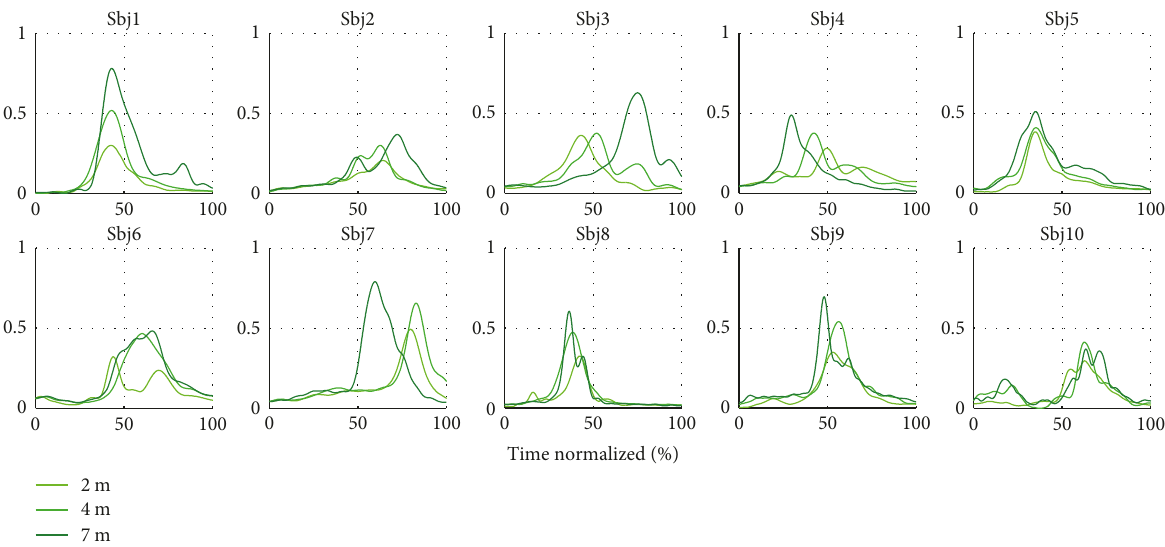
Figure 14: Average combination coe ffi cient c